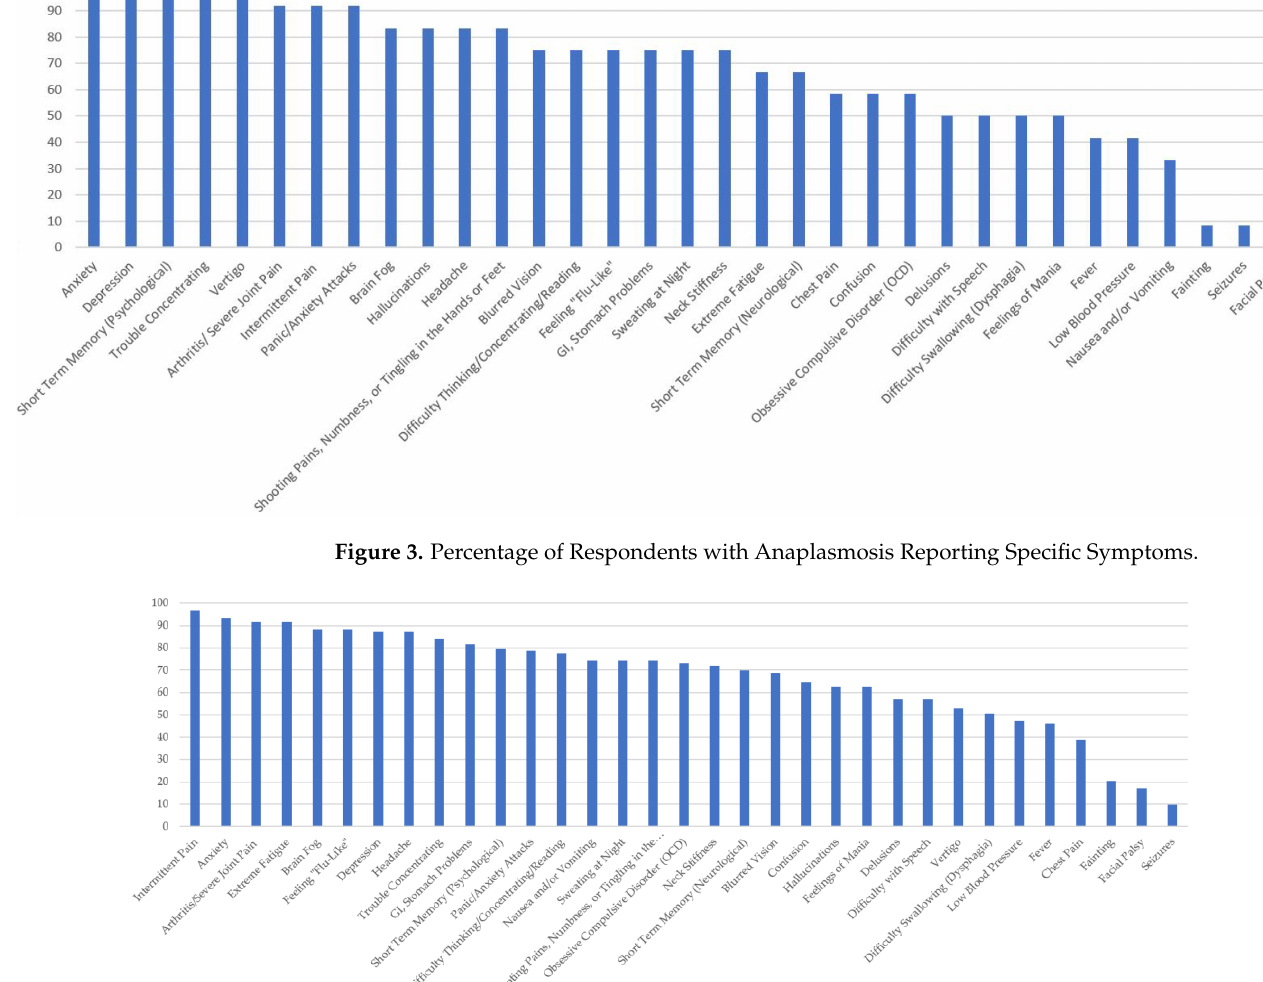
Figure 3. Percentage of Respondents with Anaplasmosis Reporting Specific Symptoms.